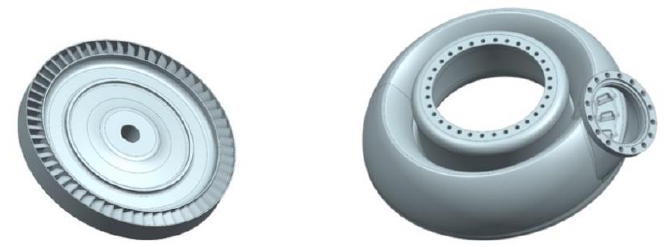
Figure 3. The additive manufacturing (AM) turbine components; rotor ( left ) and manifold ( right ) (courtesy of GKN Aerospace).